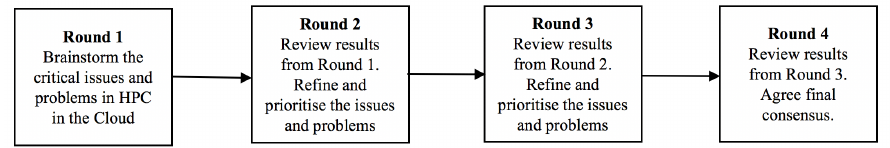
Figure 2. Modified Delphi